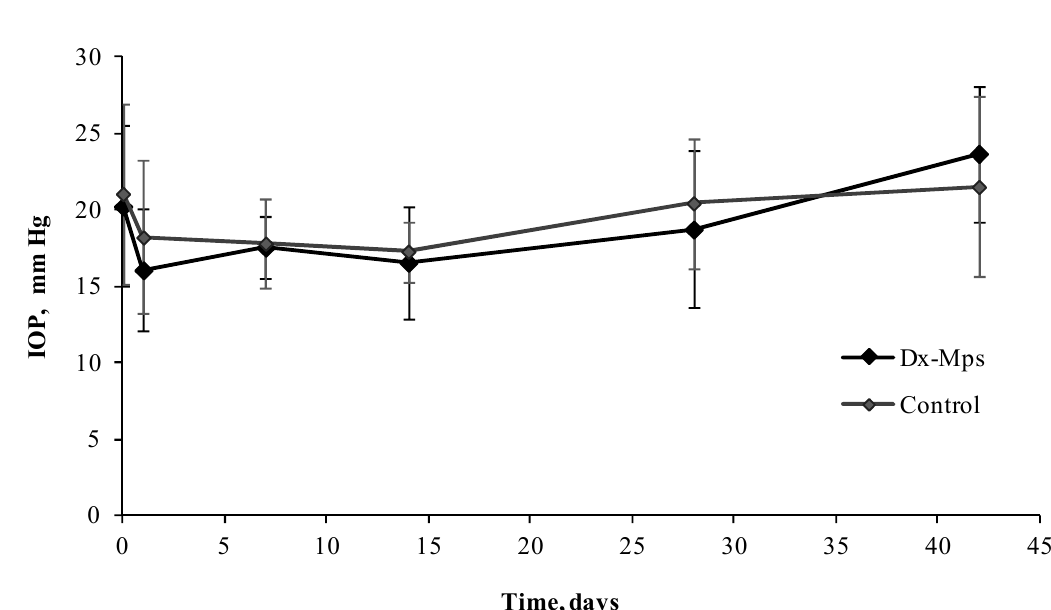
Figure 8. Intraocular pressure (IOP) mean values ( ± standard error of the mean (SEM)) obtained at different times of the study: before injection, and 1, 7, 14, 28, and 42 days after injection, for control and eyes that received a sub-Tenon injection of Dx-MS. No significant differences were found between groups ( p > 0.05).